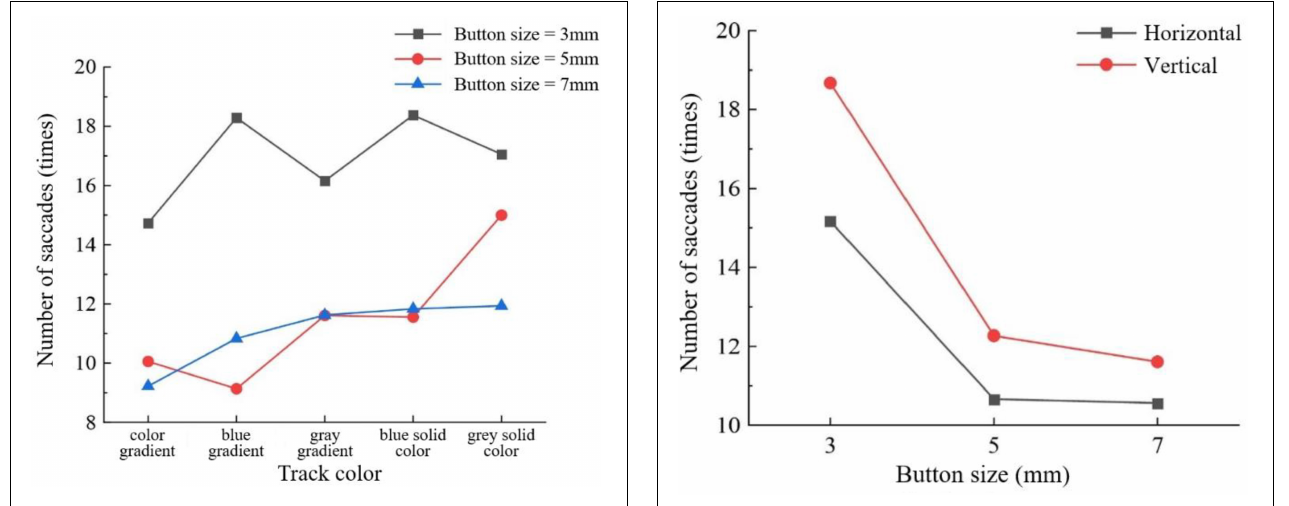
FIGURE 5 | Number of saccades by track color and button size for the middle-aged and elderly group.